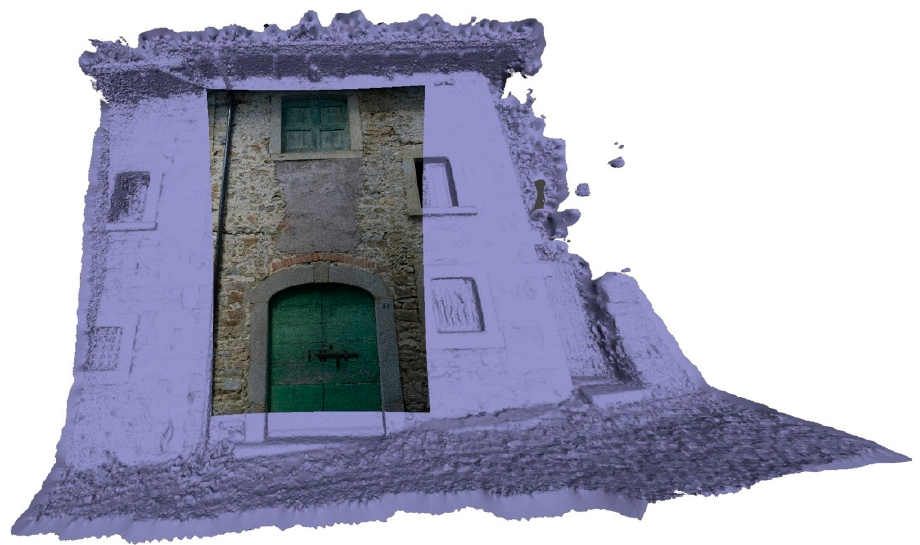
Figure 12. Structure from Motion model from the photogrammetry survey of a case study building in the historic centre of Cornillo Nuovo—SISMI project [41].